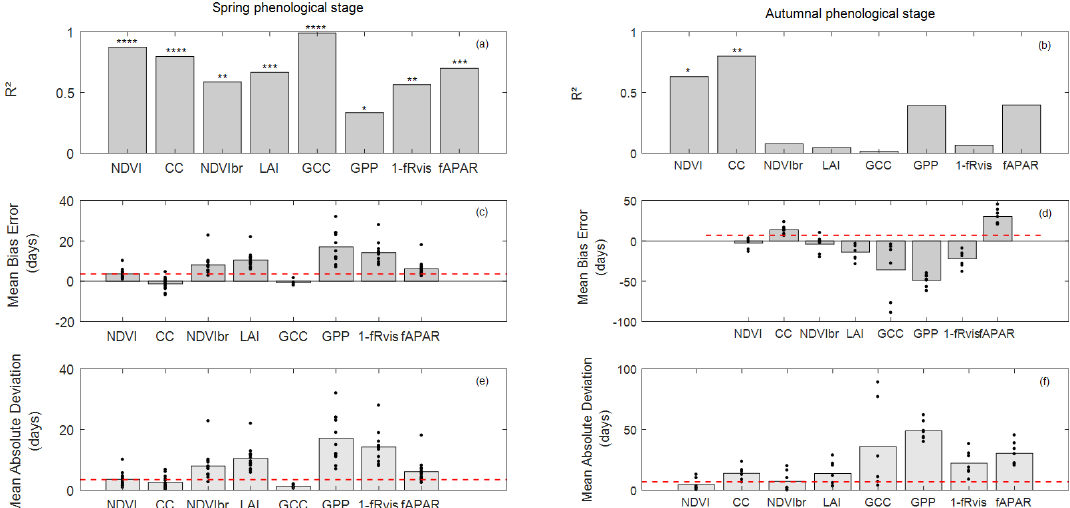
Figure 4. Coefficient of determination ( R 2 ) (a, b) , mean bias error (MBE) (c, d) and mean absolute deviation (MAD) (e, f) in days between observed and estimated phenological dates using MOS and MOF markers during spring (a, c, e) and autumnal (b, d, f) phenological stages. The significance levels of R 2 are given by stars: ∗ P< 0 . 05, ∗∗ P< 0 . 01, ∗∗∗ P< 0 . 001 and ∗∗∗∗ P< 0 . 0001. The height of grey boxes marks the average of the statistics across study years (individual years are represented by the black dots). Red horizontal lines represent temporal-resolution-related uncertainties associated with field phenological observations of 3.5d during the spring and of 7d during the